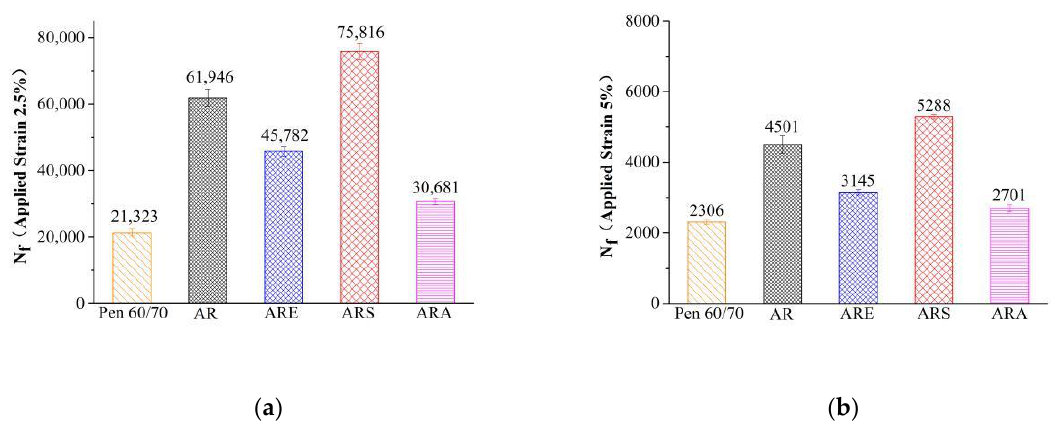
Figure 4. Results of the LAS test with different applied strains: ( a ) 2.5% and ( b ) 5%.